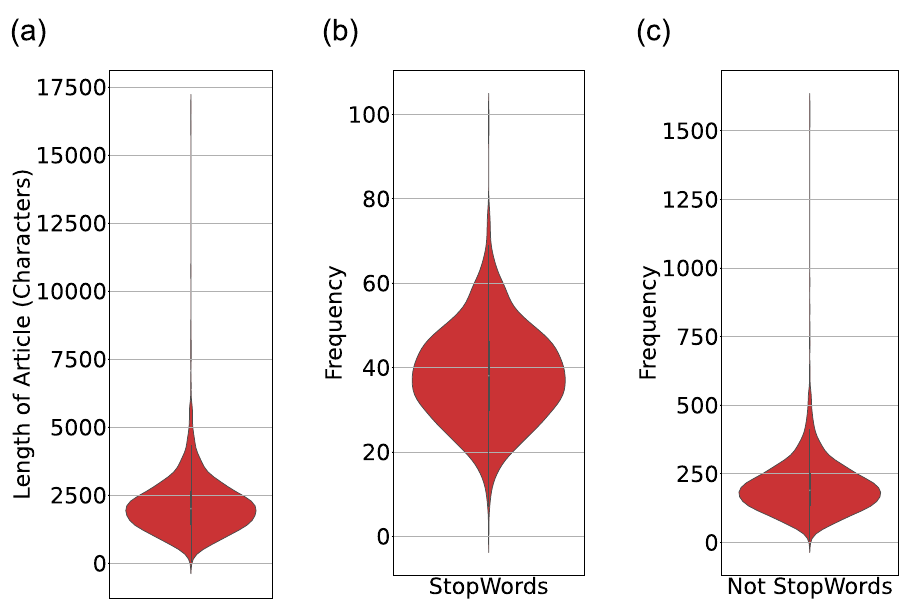
Fig 1. Illustrating the distribution of words across